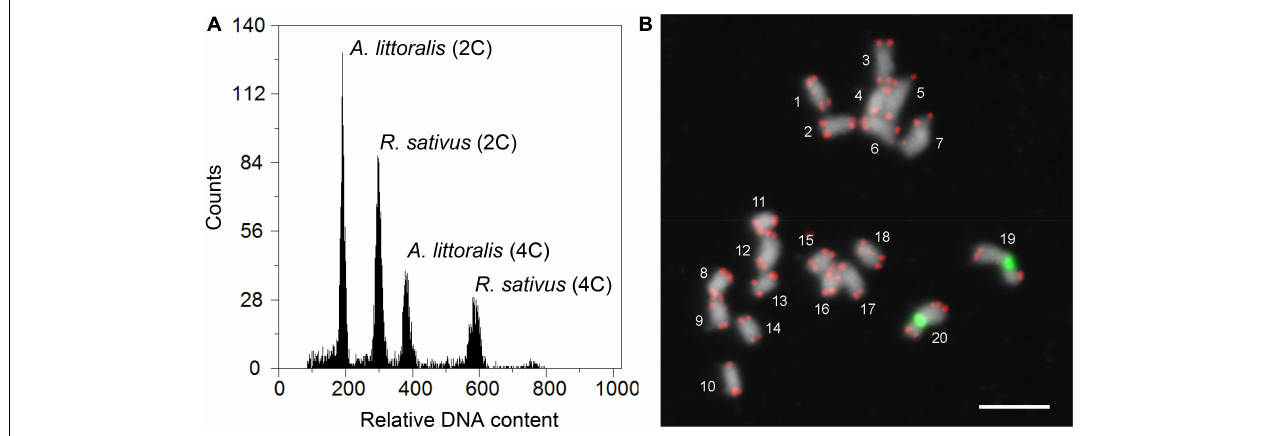
FIGURE 3 | Genome size estimation and chromosome counting of Aeluropus littoralis . (A) Measurement of A. littoralis genome size by flow cytometry. Based on the 2C-value of 1.11 pg for the internal reference Raphanus sativus , the average DNA content of diploid A. littoralis was found to be 0.724 ± 0.01 pg/2C (354 Mbp/1C). The flow cytometric histogram represents the relative fluorescence intensity of leaf nuclei between A. littoralis and R. sativus . (B) FISH mapping of telomere repeat (red) and 45S rDNA (green) clearly indicating that the chromosome number of A. littoralis is 2 n = 2x = 20. Chromosomes were counterstained with DAPI. Scale bar = 5 µ